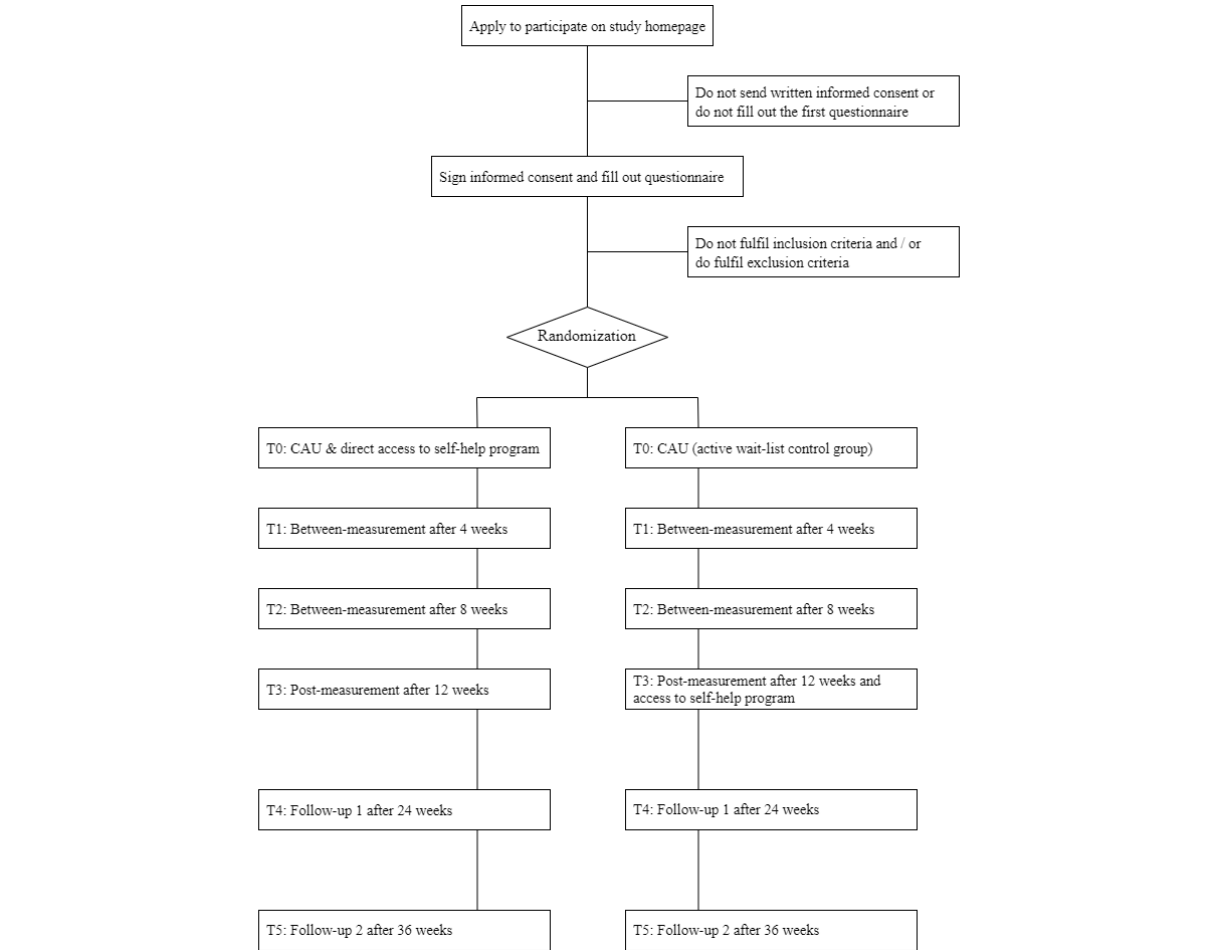
Figure 1. Flowchart of the SelFIT study design. CAU: care as